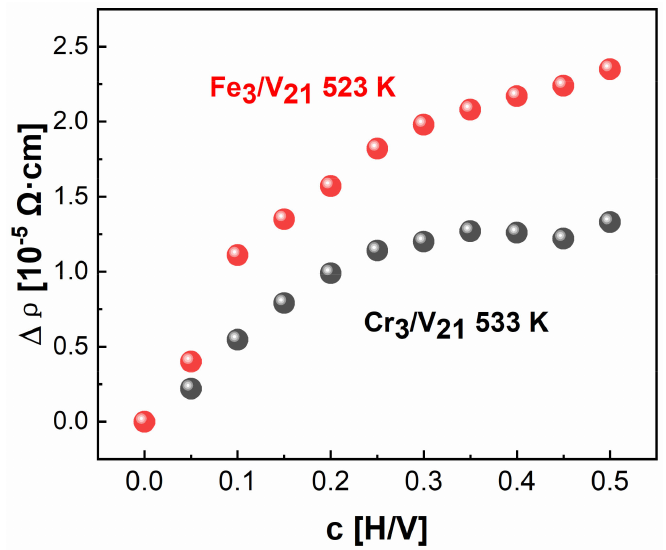
Figure 6. Excess resistivity of hydrogen in Fe/V (001) and Cr/V (001) superlattices as a function of hydrogen concentration. The Fe 3 /V 21 superlattice resistivity data was obtained in previous study but not published yet